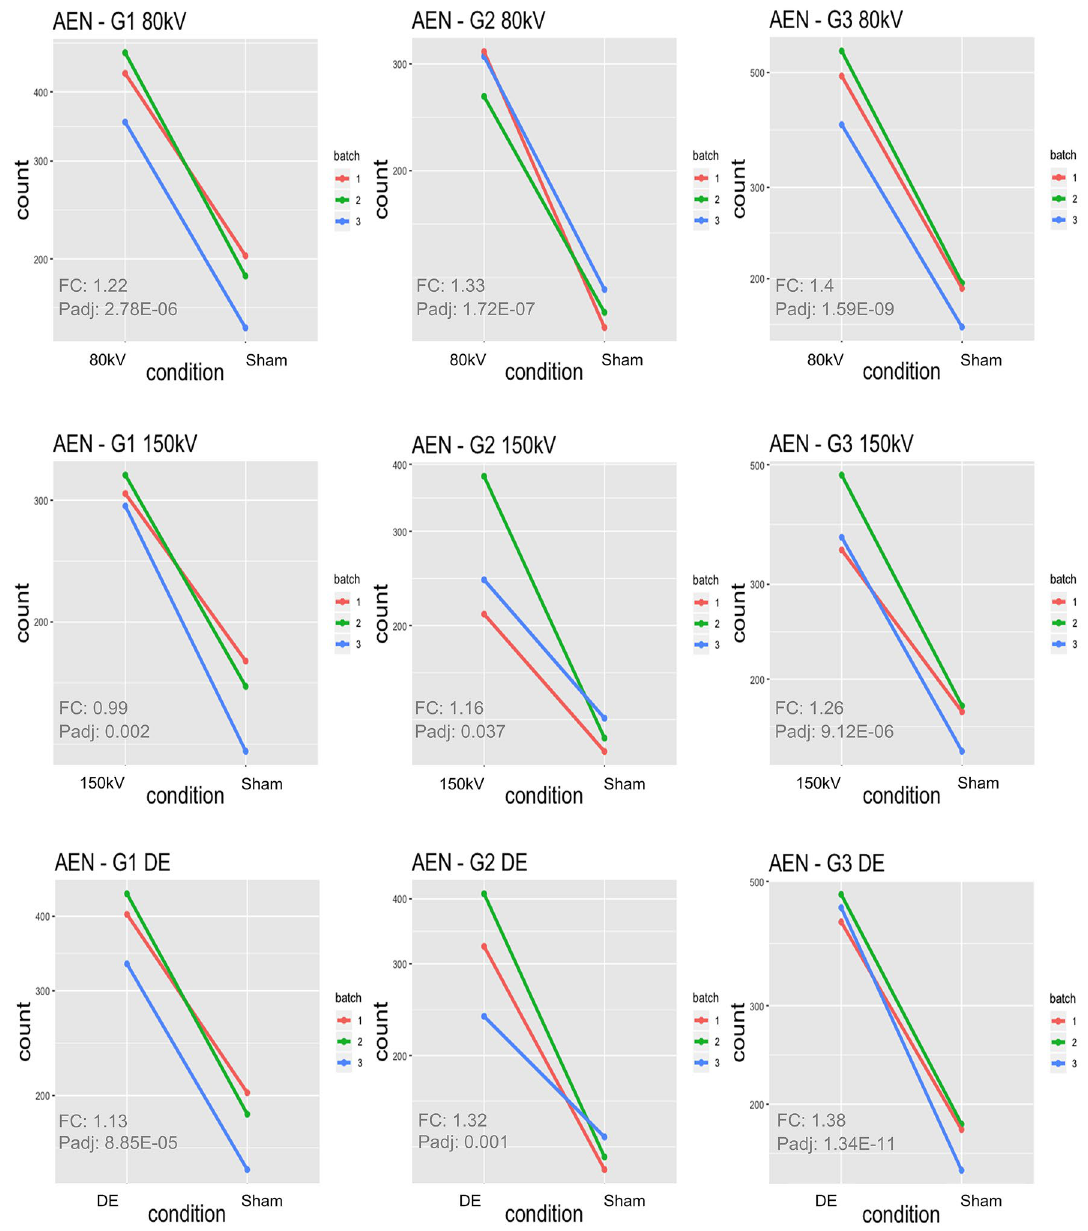
Figure 2. Gene expression plots for AEN for 80 kV single-energy CT (SECT), 150 kV SECT and dual-energy CT (DE) irradiation: Each plot depicts gene counts obtained from RNA sequencing data of the respective proband (G1-3) with post-irradiation gene count displayed to the left and corresponding sham-irradiated gene counts displayed to the right. Colored lines (green, blue and red) indicate the three replicate